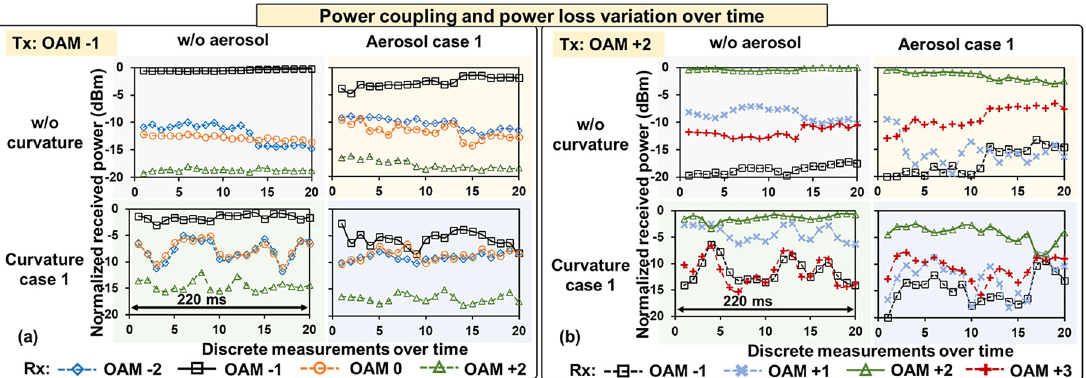
Figure 6: The power on each mode when (a) OAM − 1 and (b) OAM + 2 are transmitted. Each measurement takes ∼ 11 ms. The aerosol and curvature conditions with the same measurement number are different for different scenariosand different transmitted modes,and therefore they can ’ t be compared directly. The incident angle is 0 (normal incidence). The power is normalized by the maximum received power for the transmitted mode in the absence of interface